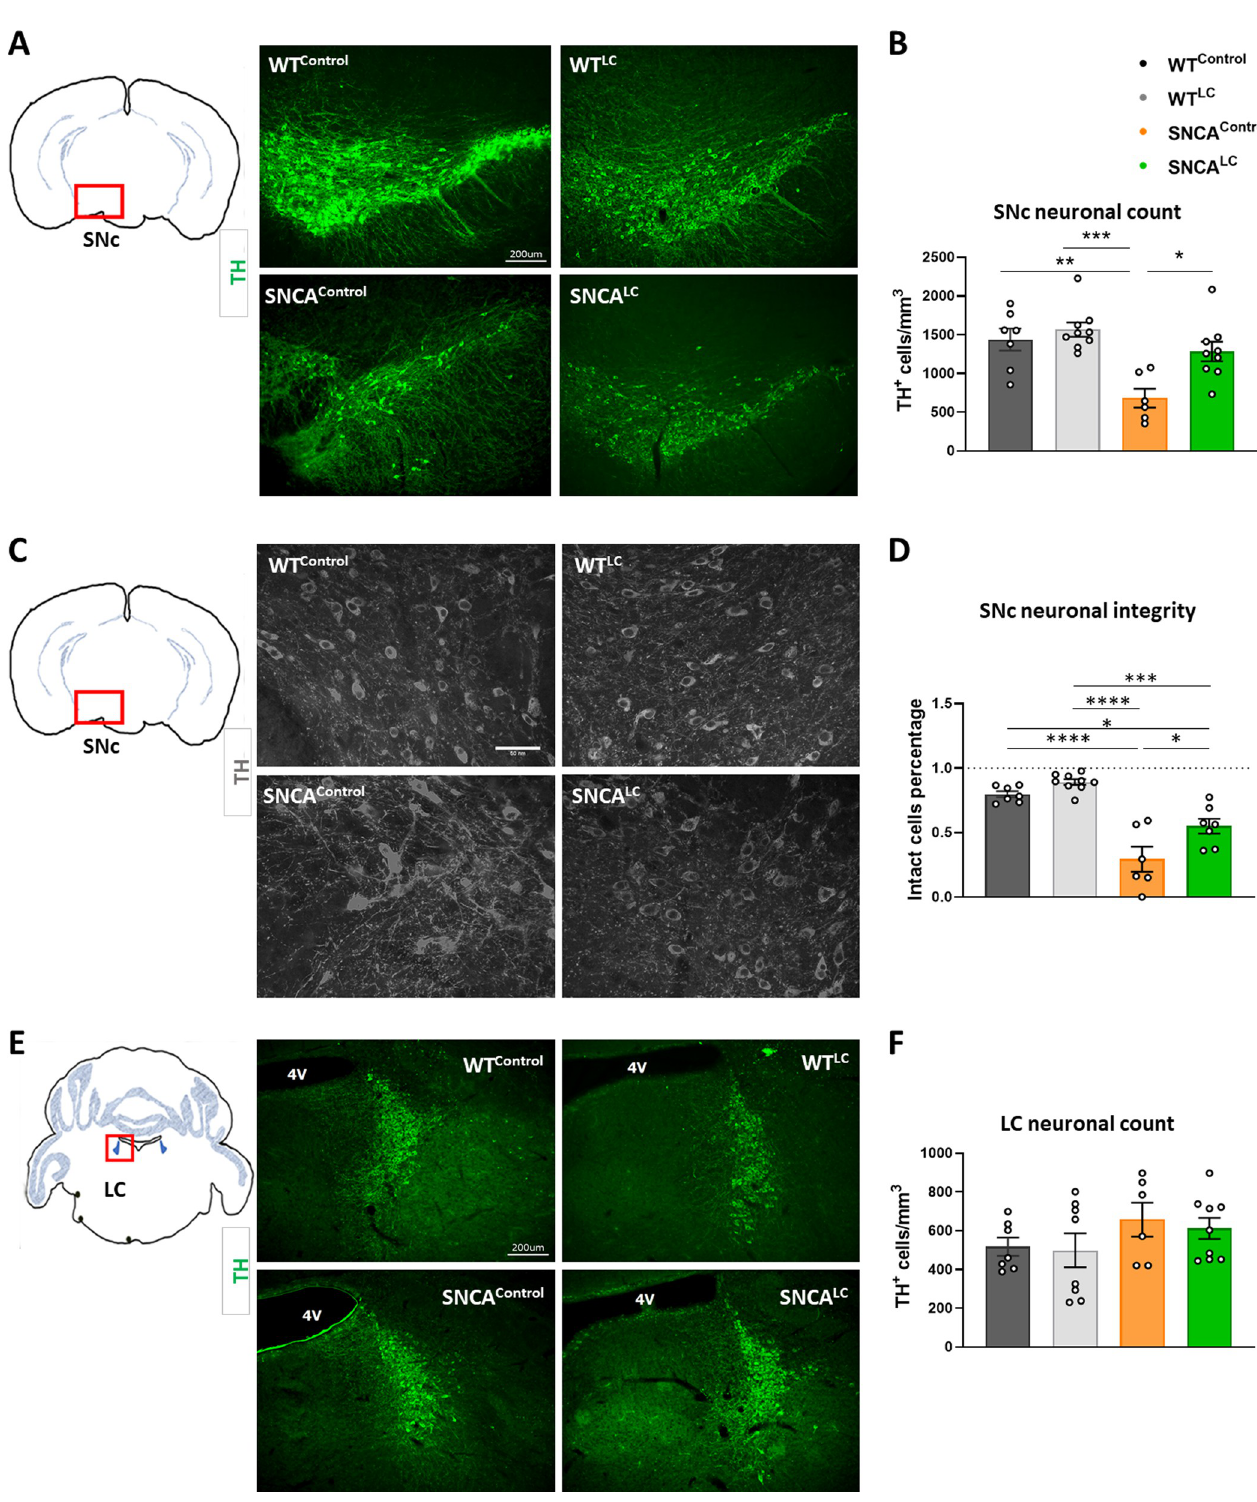
Fig 3. Neuroprotective effect of LC-NE action on SNc dopaminergic neurons. A-Representative images of TH staining in SNc from all groups, TH (green), scale 200 μ m. B-TH-positive cells count in SNc (n = 6–9). C- Representative absolute-eigen images of TH staining from all groups in SNc, scale 50 μ m. D- Quantification of TH + cellular morphology integrity in SNc (n = 6–9). E- Representative images of TH staining in LC from all groups, TH (green), scale 200 μ m. G- Quantification of TH-positive cells in LC (n = 6–9). ���� p < 0.00001, ��� p < 0.0001, �� p < 0.001, � p < 0.05, all values denote means ± SEM.